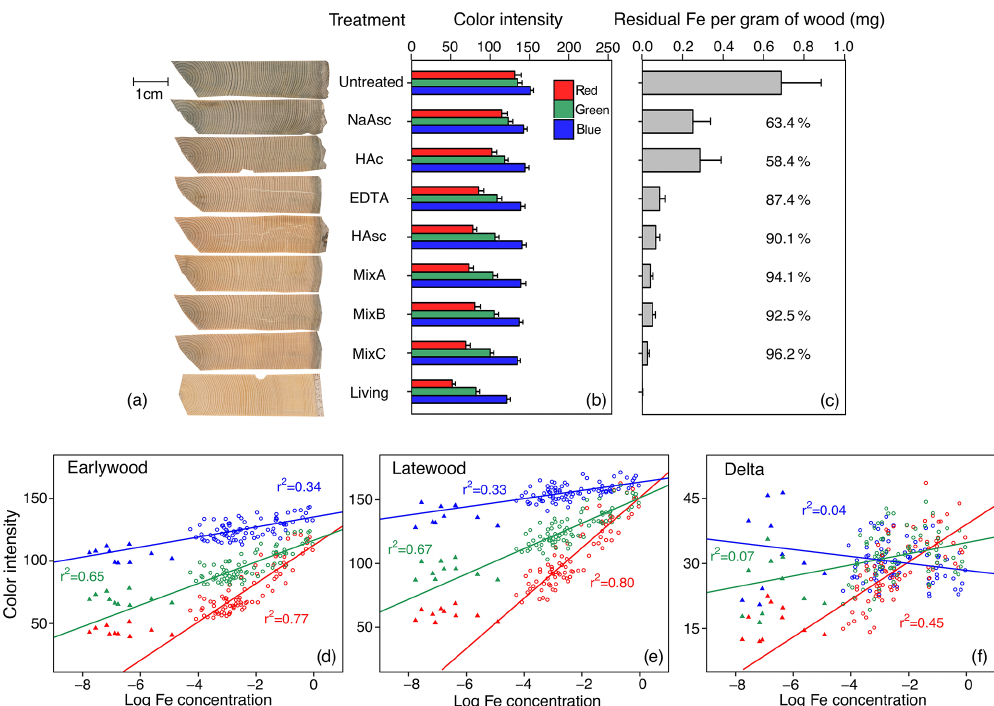
Figure 3. Residual iron (Fe) and wood RGB intensities (see definitions in Table 2) of LST laths treated with seven chemical reagents. Panel (a) shows examples of treated laths from one LST sample and one living-tree sample (last row). The gray outer part of the example LST is discolored due to decay. Panel (b) shows the mean wood RGB intensities according to treatment. Panel (c) shows the mean concentrations of residual Fe according to treatment. Error bars in (b) and (c) refer to standard deviations of corresponding group. Percentages in (c) refer to the Fe removed by destaining treatments relative to the Fe concentrations of untreated stained LSTs. Panels (d) – (f) show the linear regressions of earlywood, latewood, and delta RGB intensities against the log of residual Fe. Regressions are based only on the LST data (circles). Living-tree data are plotted as triangles but are excluded from the